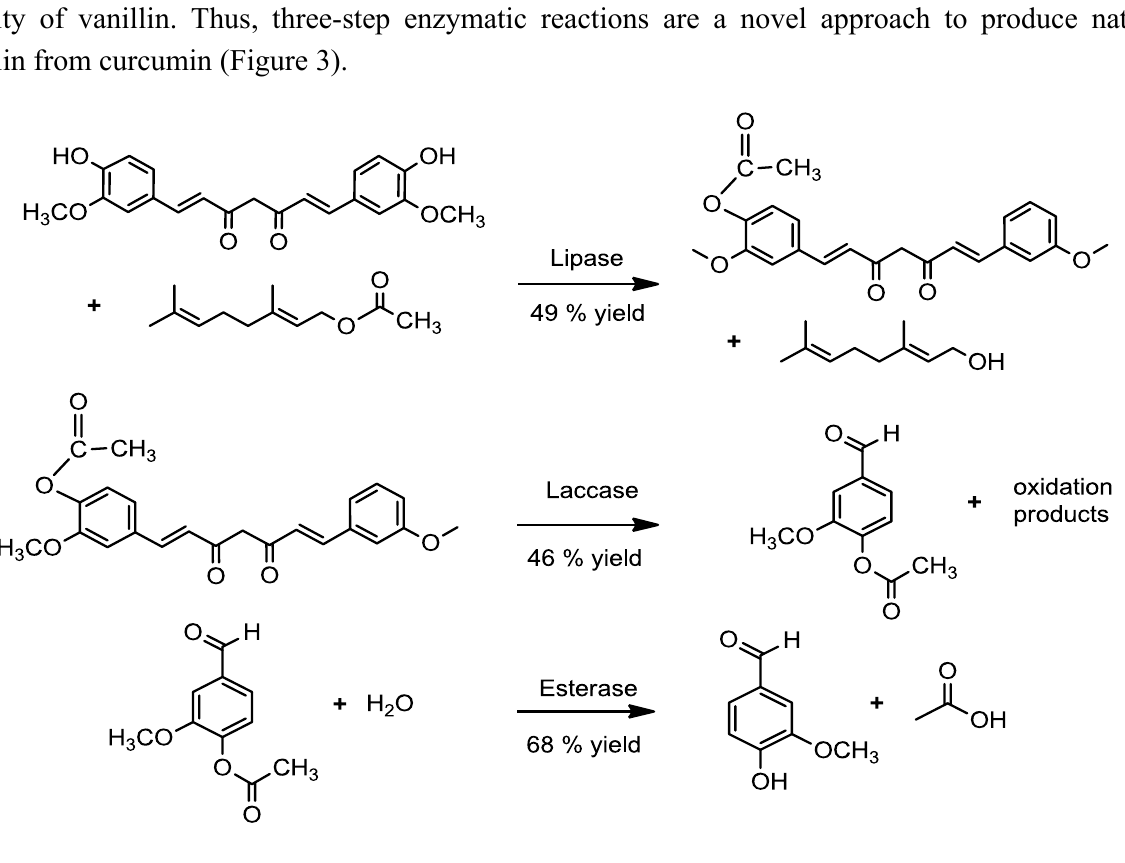
Figure 3. Three-step enzymatic bioconversion of curcumin to natural